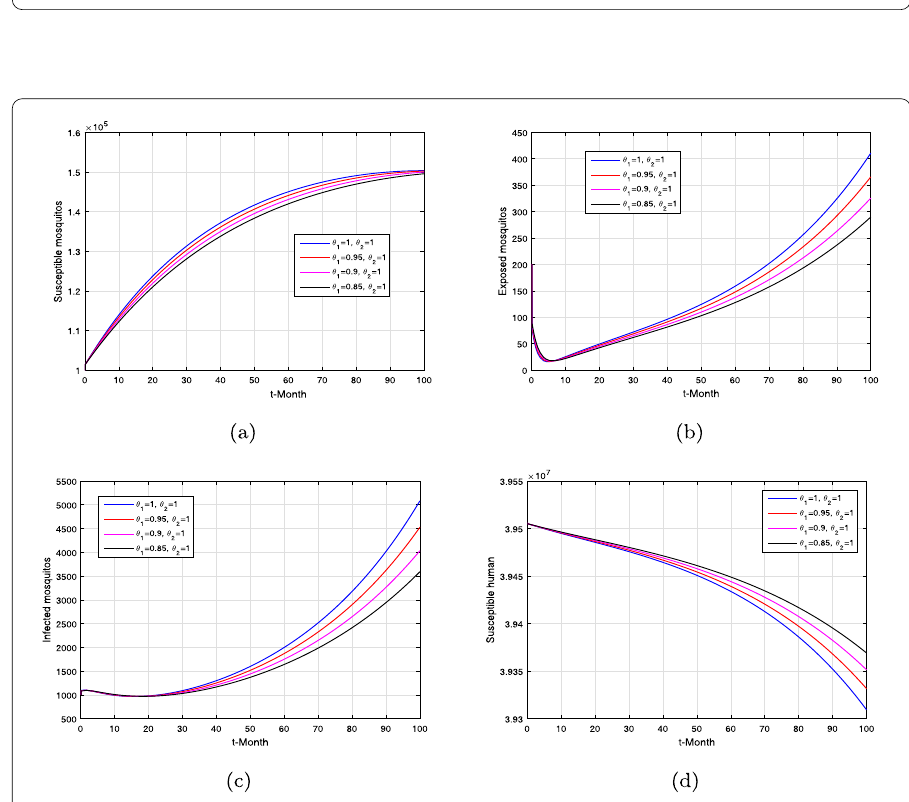
Figure 2 Simulation of the fractal-fractional model (10) when θ 1 = 1,0.95,0.9,0.85 and fractal order θ 2 = 1 where ( a ) susceptible mosquitos, ( b ) exposed mosquitos, ( c ) infected mosquitos, ( d ) susceptible